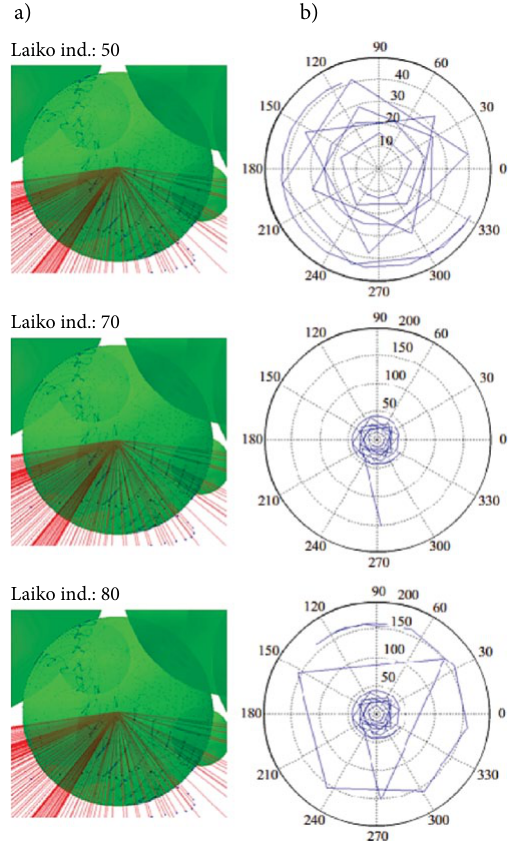
Fig. 10. Formation of fields pertaining to the i th particle’s velocity vectors and their normal planes in the polydispersed mixture: a – texture formed at particular time on the surface of the particle of the intersection between normal planes of velocity vectors; b – change of the velocity vector’s direction in the polar coordinate system; c – the central part of the chart.